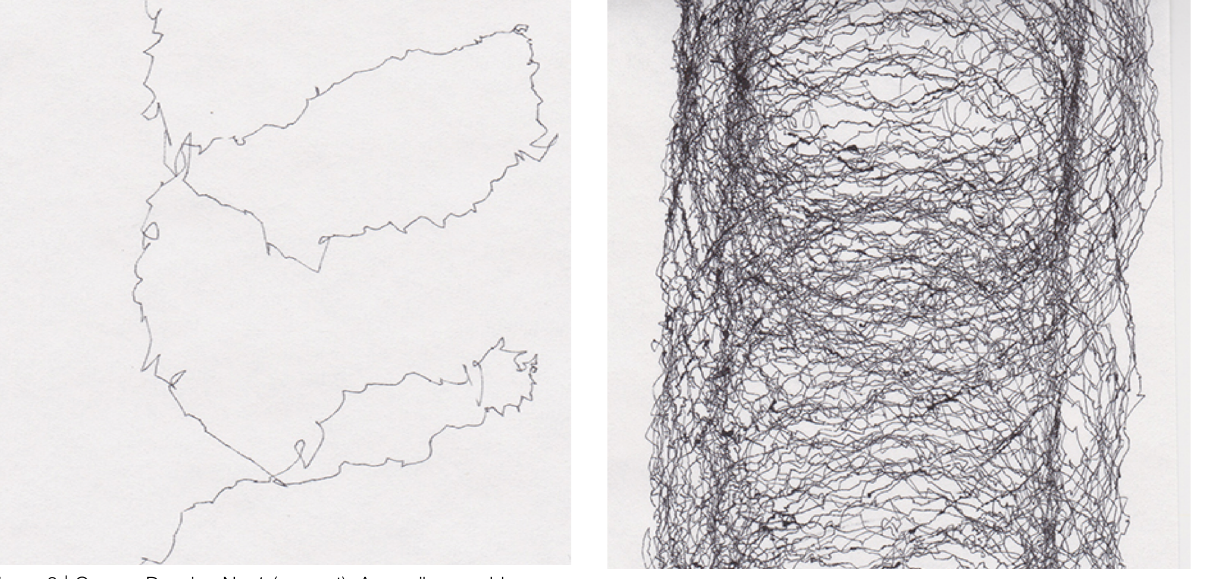
Figure 4 | Opener Drawing Nr. 3 (excerpt). Two pens are attached, resulting in dense double spirals with slightly different